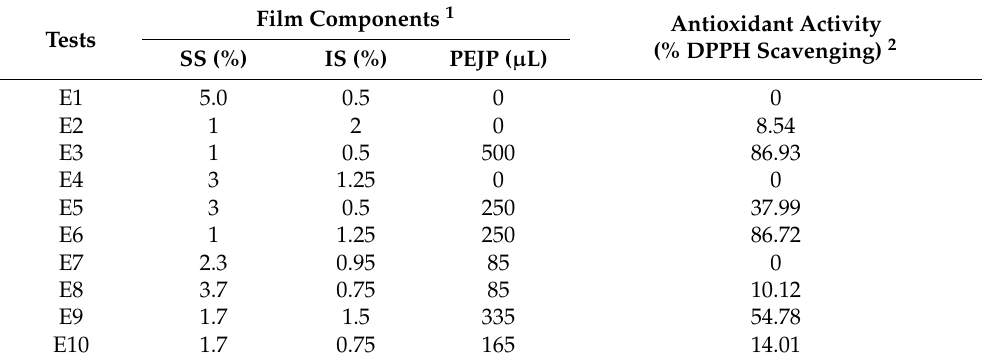
Table 1. Mixture design and DPPH scavenging activity for the different formulations of starch- PEJP